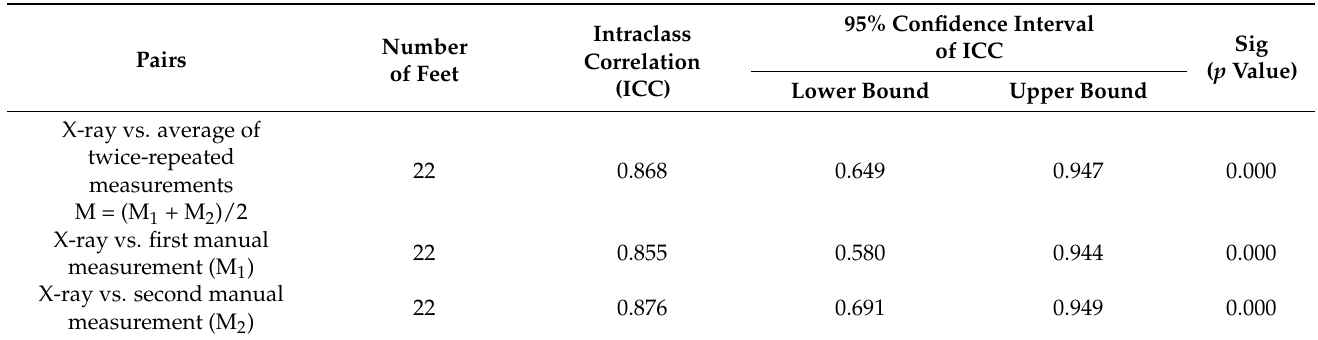
Table 3. Intraclass correlation coefficient (ICC).